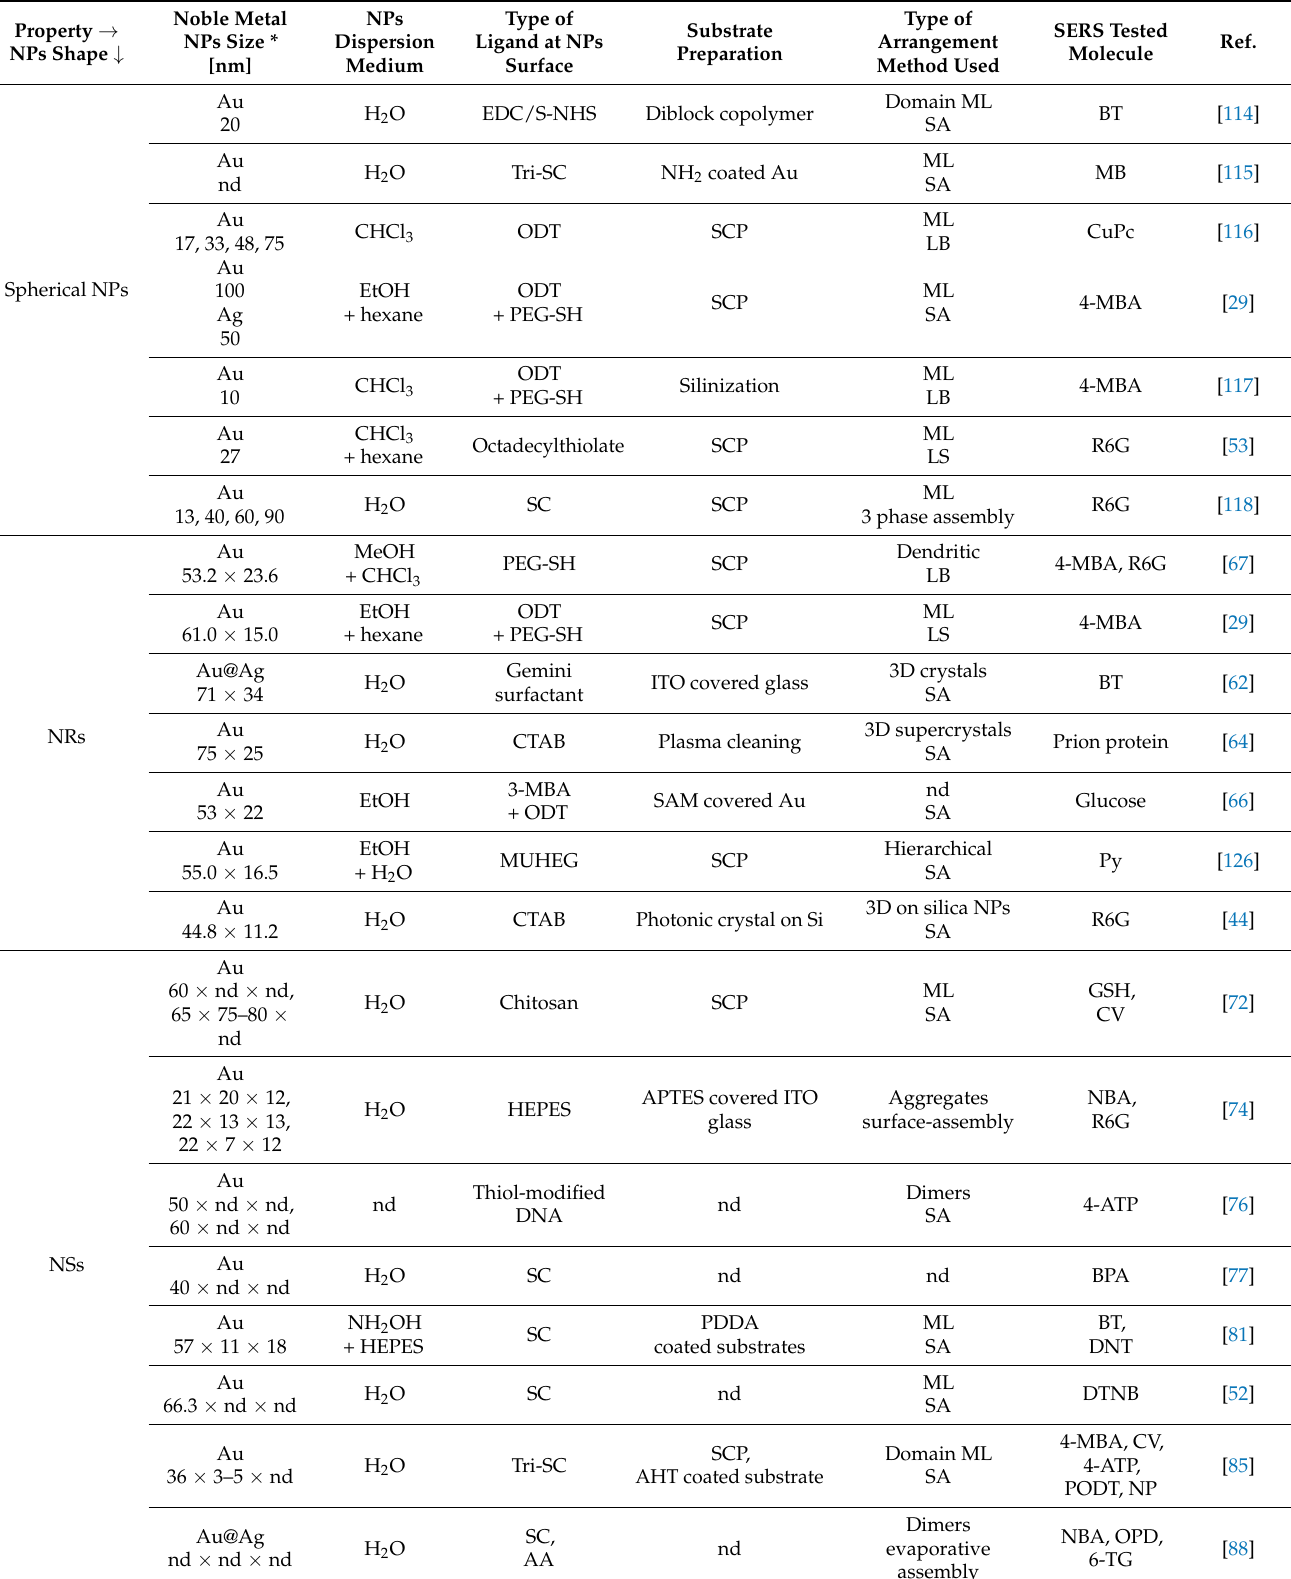
Table 1. Basic functional properties of the noble metal nanoparticles and their arranged